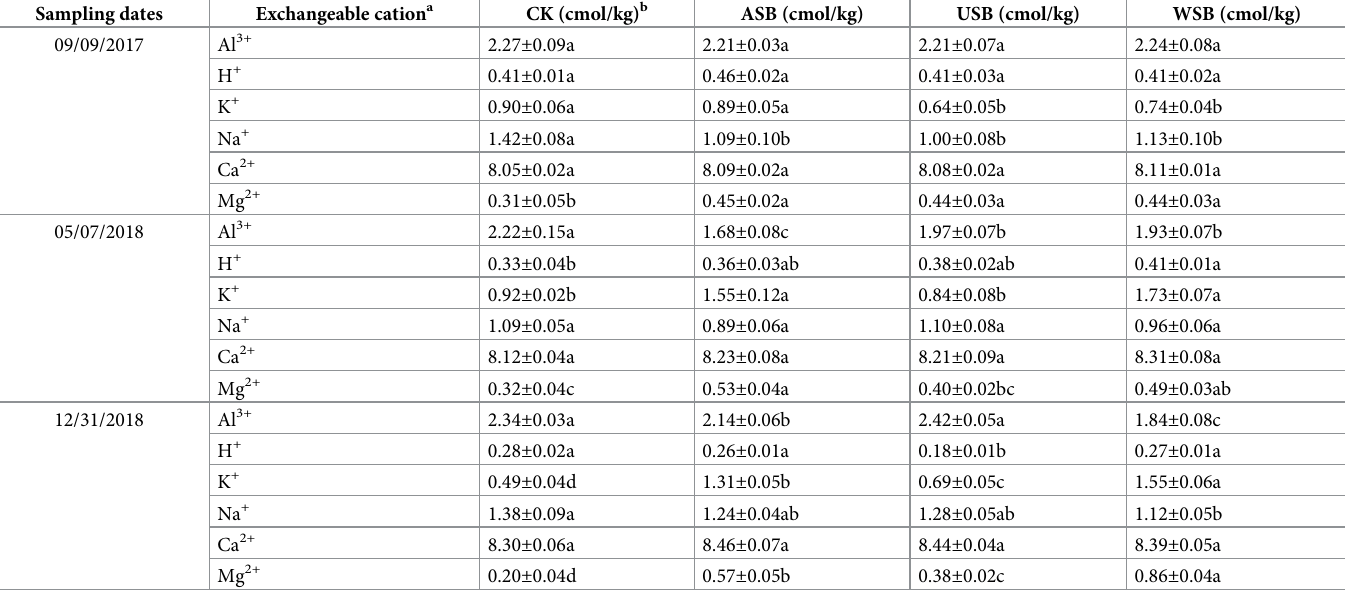
Table 2. Exchangeable cations of tea garden soil in soybean planting and covering